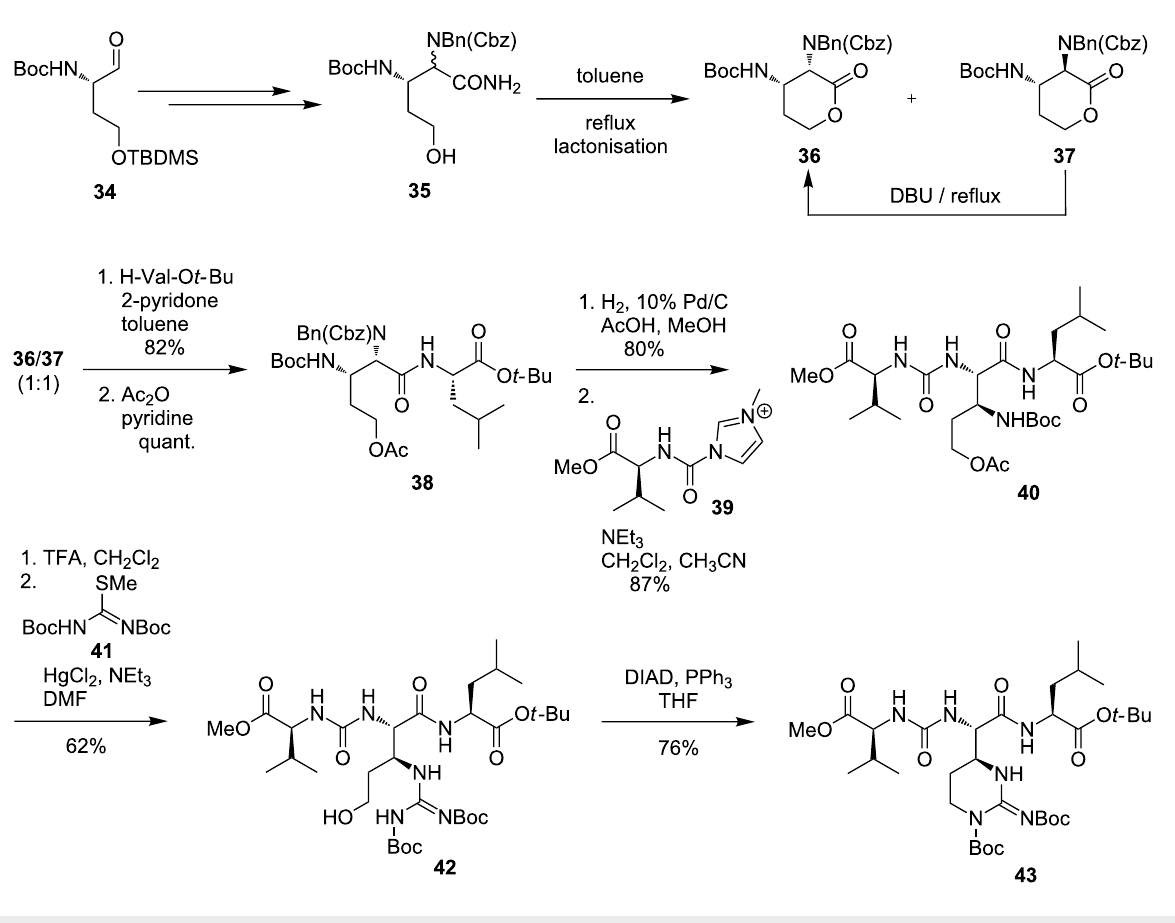
Scheme 5: Synthesis of the urea tripeptide unit as a building block for muraymycins reported by Kurosu et al.